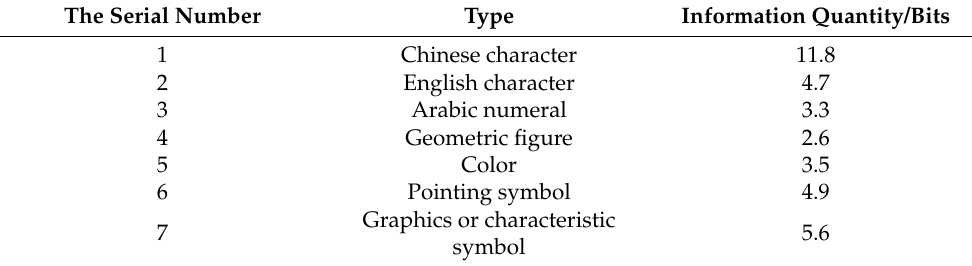
Table 2. The information quantity for each traffic sign information